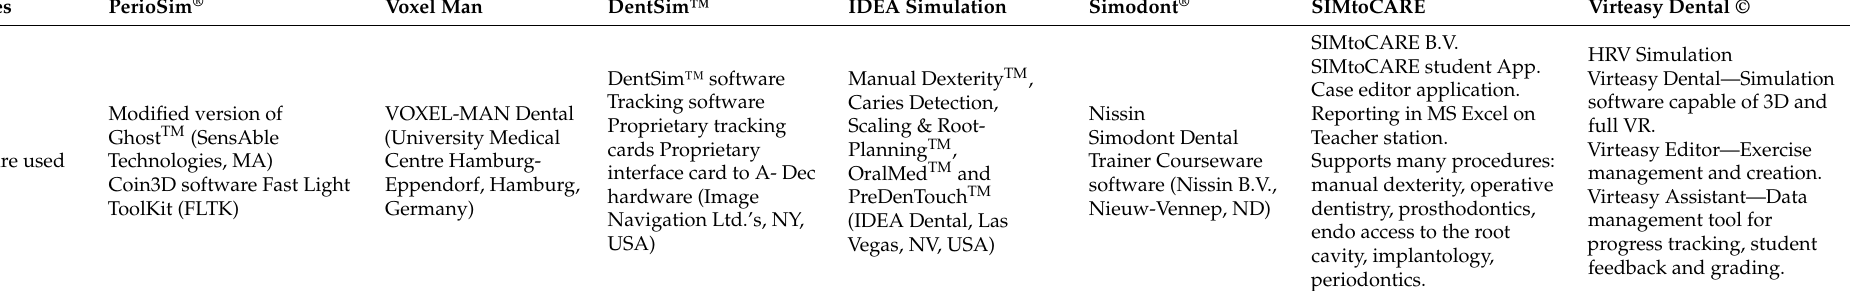
Table 1. Comparison of commercially available dental simulators. (Adapted and modified from the E. Roy et al.